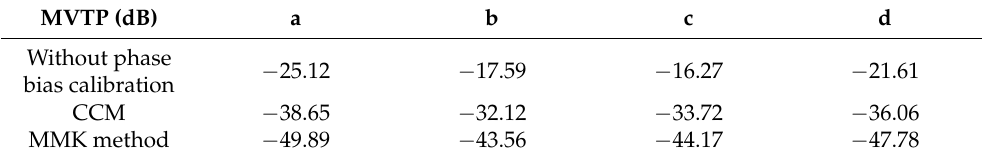
Figure 8. Focused SAR image. ( a ) SAR image processed without phase bias calibration. ( b ) SAR image processed with calibration using the CCM. ( c ) SAR image processed with calibration using the proposed approach. Table 3. Main parameters of real airborne data. Table 4. Maximum virtual target